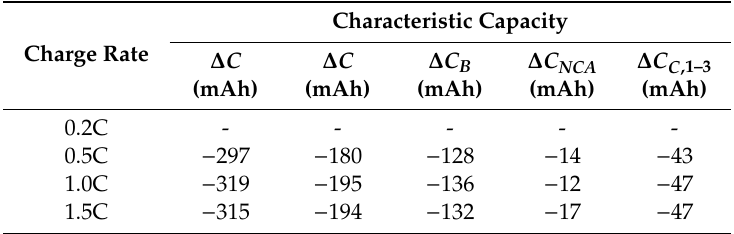
Table A4. Change of characteristic capacities after load cycle 14 at 10 ◦